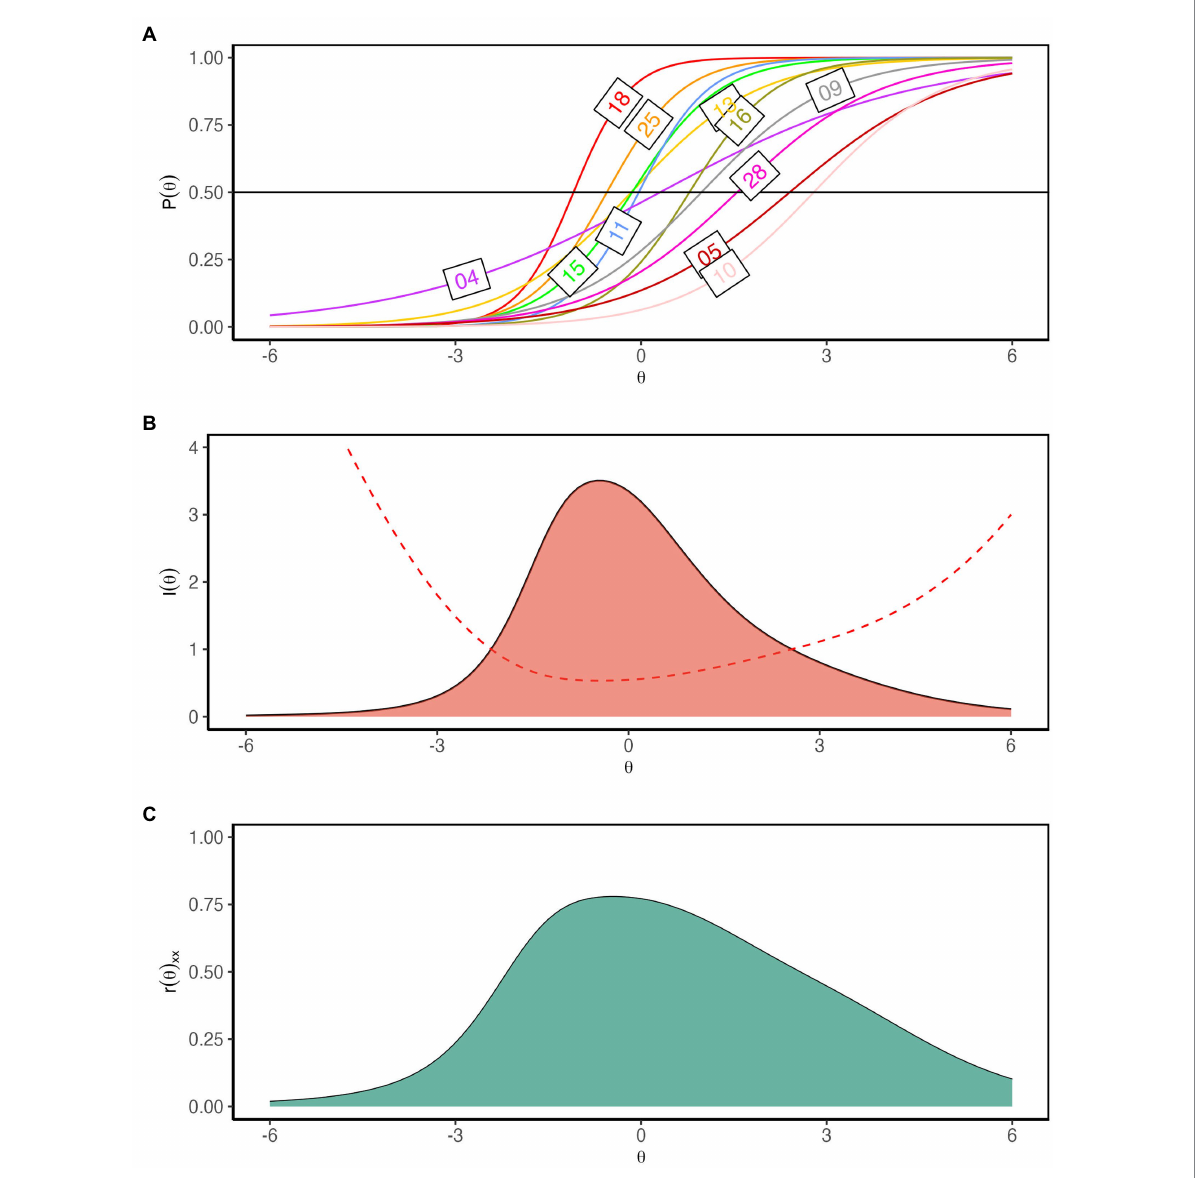
FIGURE 6 (A) Item characteristic curves (ICC) of the 11 items of the Bangla Rotter I-E scale. ICC indicates Bangla Rotter I-E scale is composed of easy (18 and 25), medium (4, 11, 13, 15), hard (9, 16, 28) and very hard items (5 and 10). (B) Test information curve. The curve’s peak is centered between the θ range − 1–0.3. (C) Reliability plot. The scale’s reliability was 0.70 and above between θ = − 1.4 and θ =